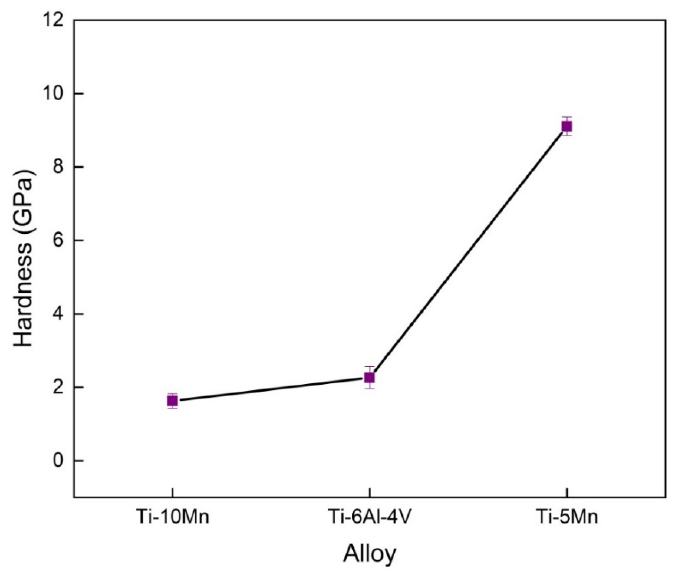
Figure 5. The nanohardness of the titanium-based alloys. Table 2. The hardness values of α and β phases and the bulk sample.